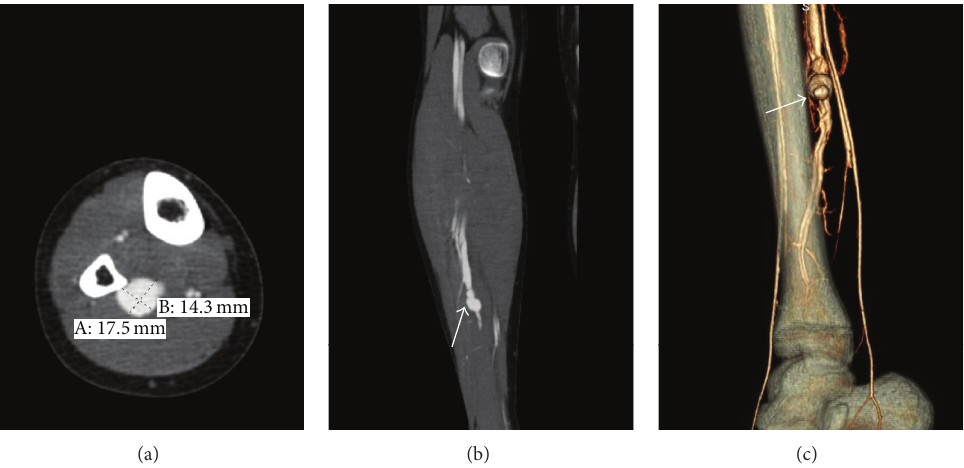
Figure 2: CT angiogram of the right lower extremity. (a) Axial, (b) coronal, and (c) volume rendered images show a 1.8 × 1.4 cm contrast filled pseudoaneurysm arrow with a direct communication between the peroneal artery and peroneal vein. Early venous filling indicated an arteriovenous fistula.